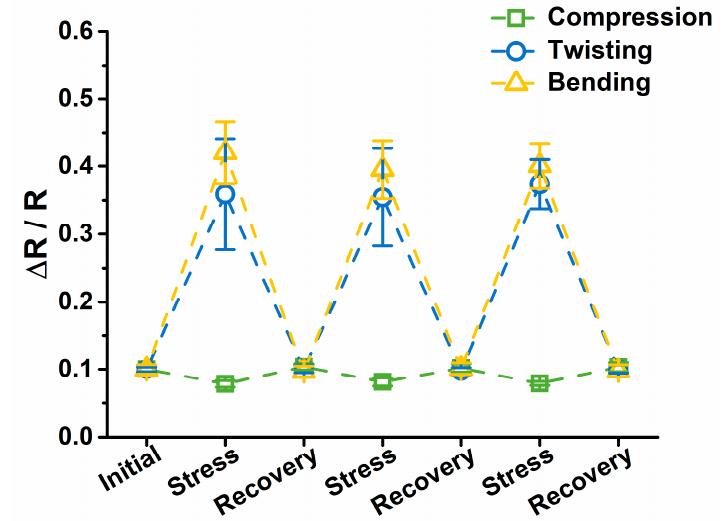
Figure 6. Sensing functions of DCDFs under 0.5 V of applied voltage. Changes of the thin film conductivity versus repeated loading weight of 50 g, repeated twisting of 180°, and repeated bending of 90°. Data were obtained from DCDF2.